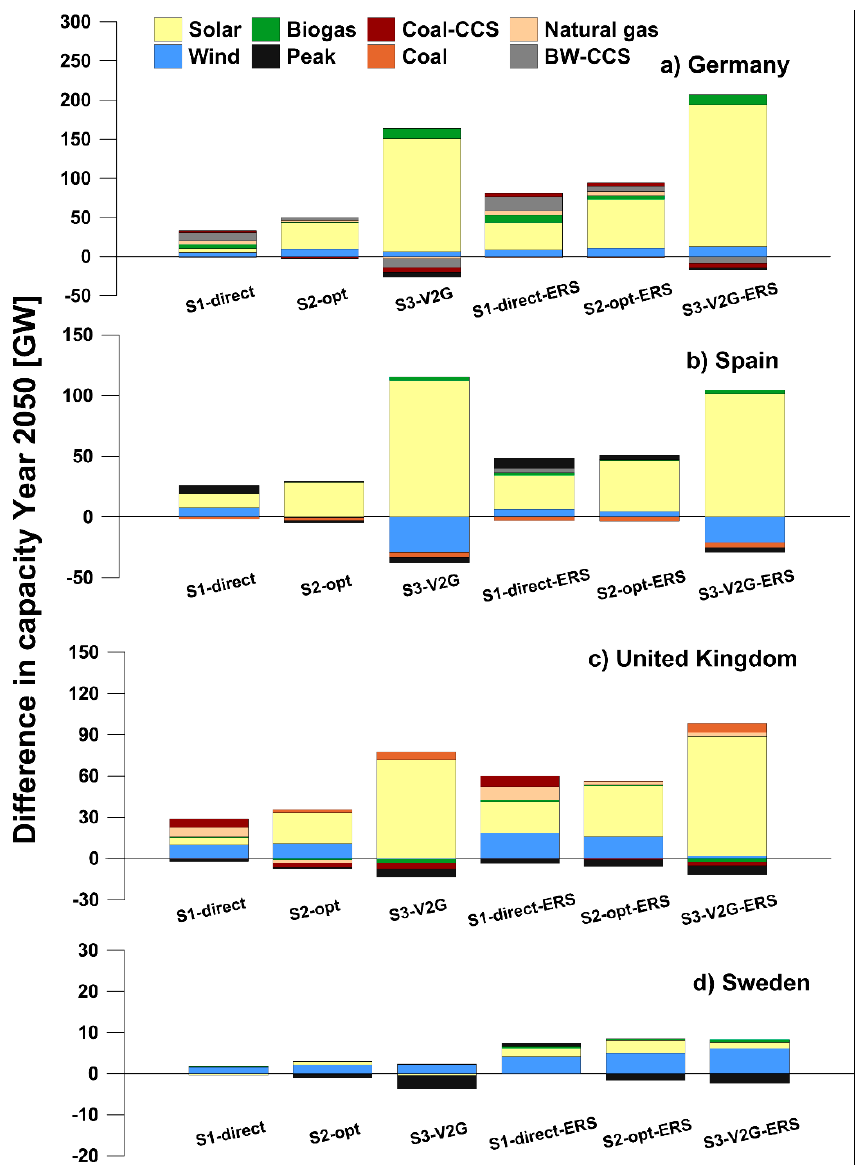
Figure 4. The differences in installed capacity Year 2050 between a scenario without EVs and the various EV and ERS scenarios investigated for: ( a ) Germany; ( b ) Spain; ( c ) the UK; and ( d ) Sweden. Opt, Optimisation of EV charging; CCS, carbon capture and storage; V2G, vehicle-to-grid; ERS, electric road system; BW, lignite co-fired with biomass. Table 3. Shares of generation from variable renewable electricity (VRE), wind and solar power in Year 2050 in the four countries investigated for the different scenarios. UK